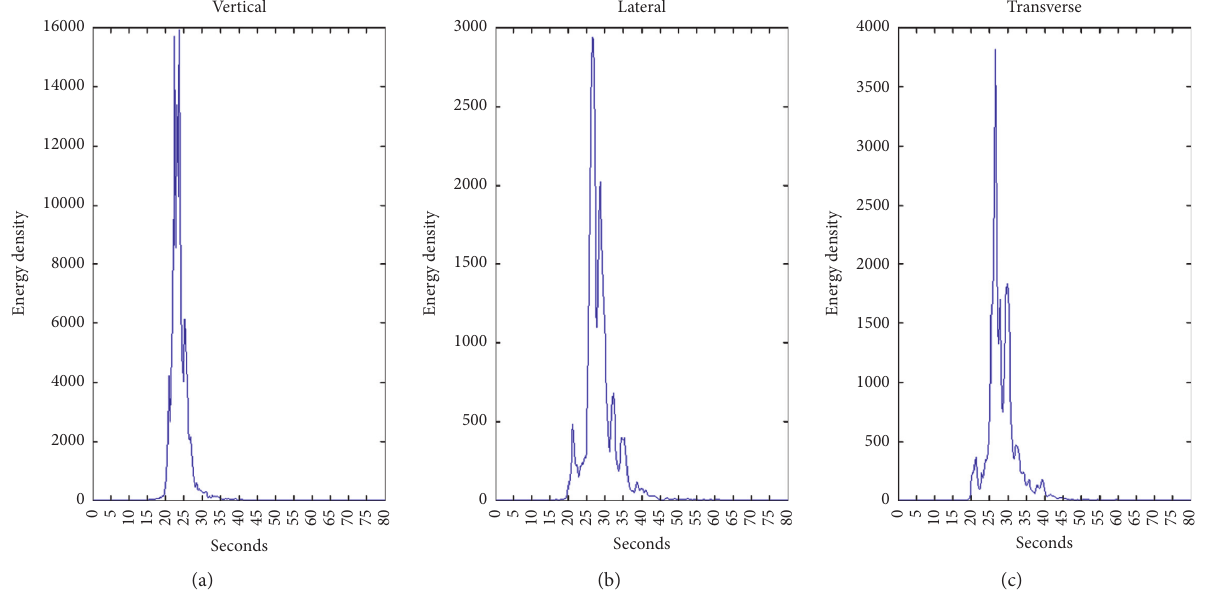
Figure 13: The instantaneous energy density estimated for Mosha earthquake at Mosha3